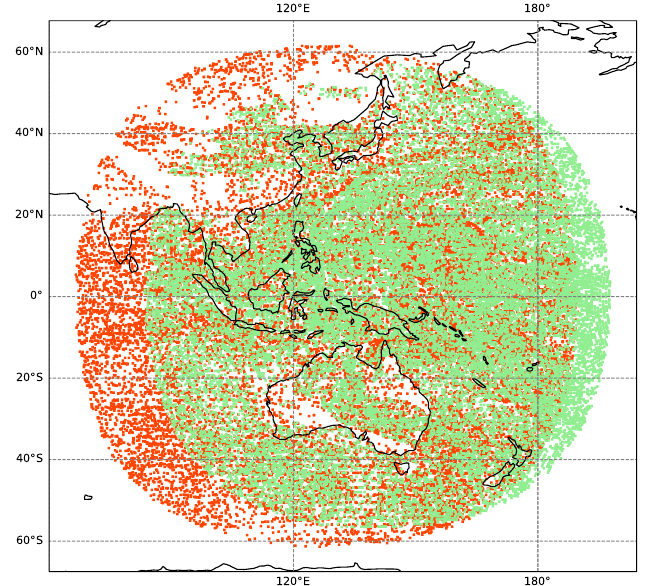
Figure 2. The spatial distribution of GK2A AMVs (orange) and H-8 AMVs (green) from GEOS ADAS on 1 December 2020.